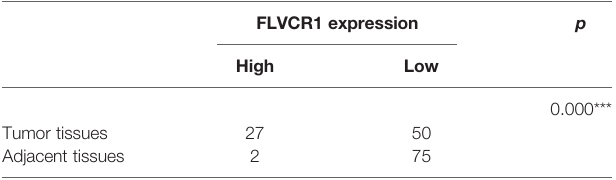
FIGURE 1 | FLVCR1 expression is upregulated in ESCC tissues and predicts a poor clinical outcome. (A) Pan-cancer analysis of FLVCR1 based on TCGA data. (B) The IHC scores of FLVCR1 in 31 matched normal tissues and ESCC tissues. (C) Representative photographs of FLVCR1 IHC staining in normal and tumor tissues. (Scale bar: 100 m m; Magni fi cation×200.) (D) The IHC scores of FLVCR1 in ESCC patients with different N stages and TNM stages. (E, F) . Forest plot showing the association between FLVCR1 expression and ESCC survival using univariate (E) and multivariate (F) analyses. (HR, hazard ratio; CI, con fi dence interval) (G) Representative images of FLVCR1 staining according to the T stage, N stage, and TNM stage of the ESCC patients (magni fi cation, 200×). (H) Comparison of overall survival of ESCC patients with different FLVCR1 TABLE 1 | Differential expression of FLVCR1 in 77 paired of ESCC and adjacent tissues.